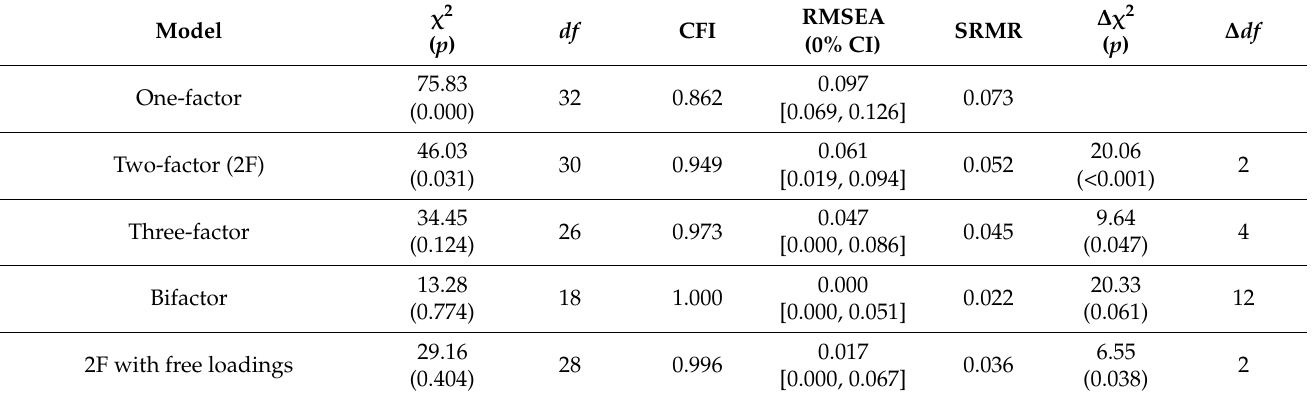
Table 2. The fit of the different PSQI structure models and their